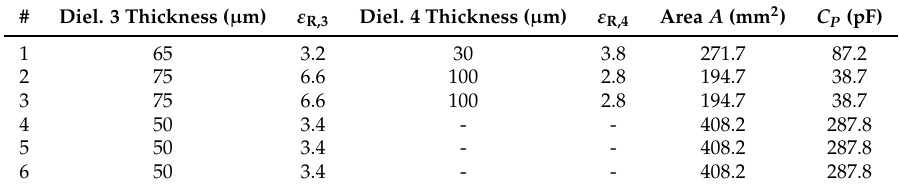
Table 4. Calculated parasitic capacity C P of various sensor assemblies. Dielectric 3 is the dielectric foil or textile. Dielectric 4 is the silicone or acrylic adhesive. C P includes the capacity of the connection in Table